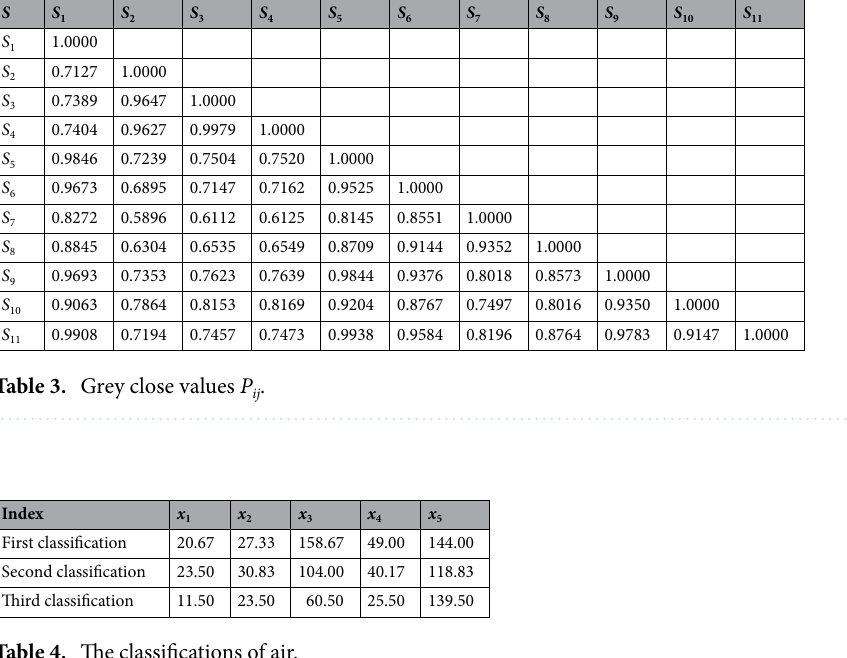
Table 4. The classifications of air.